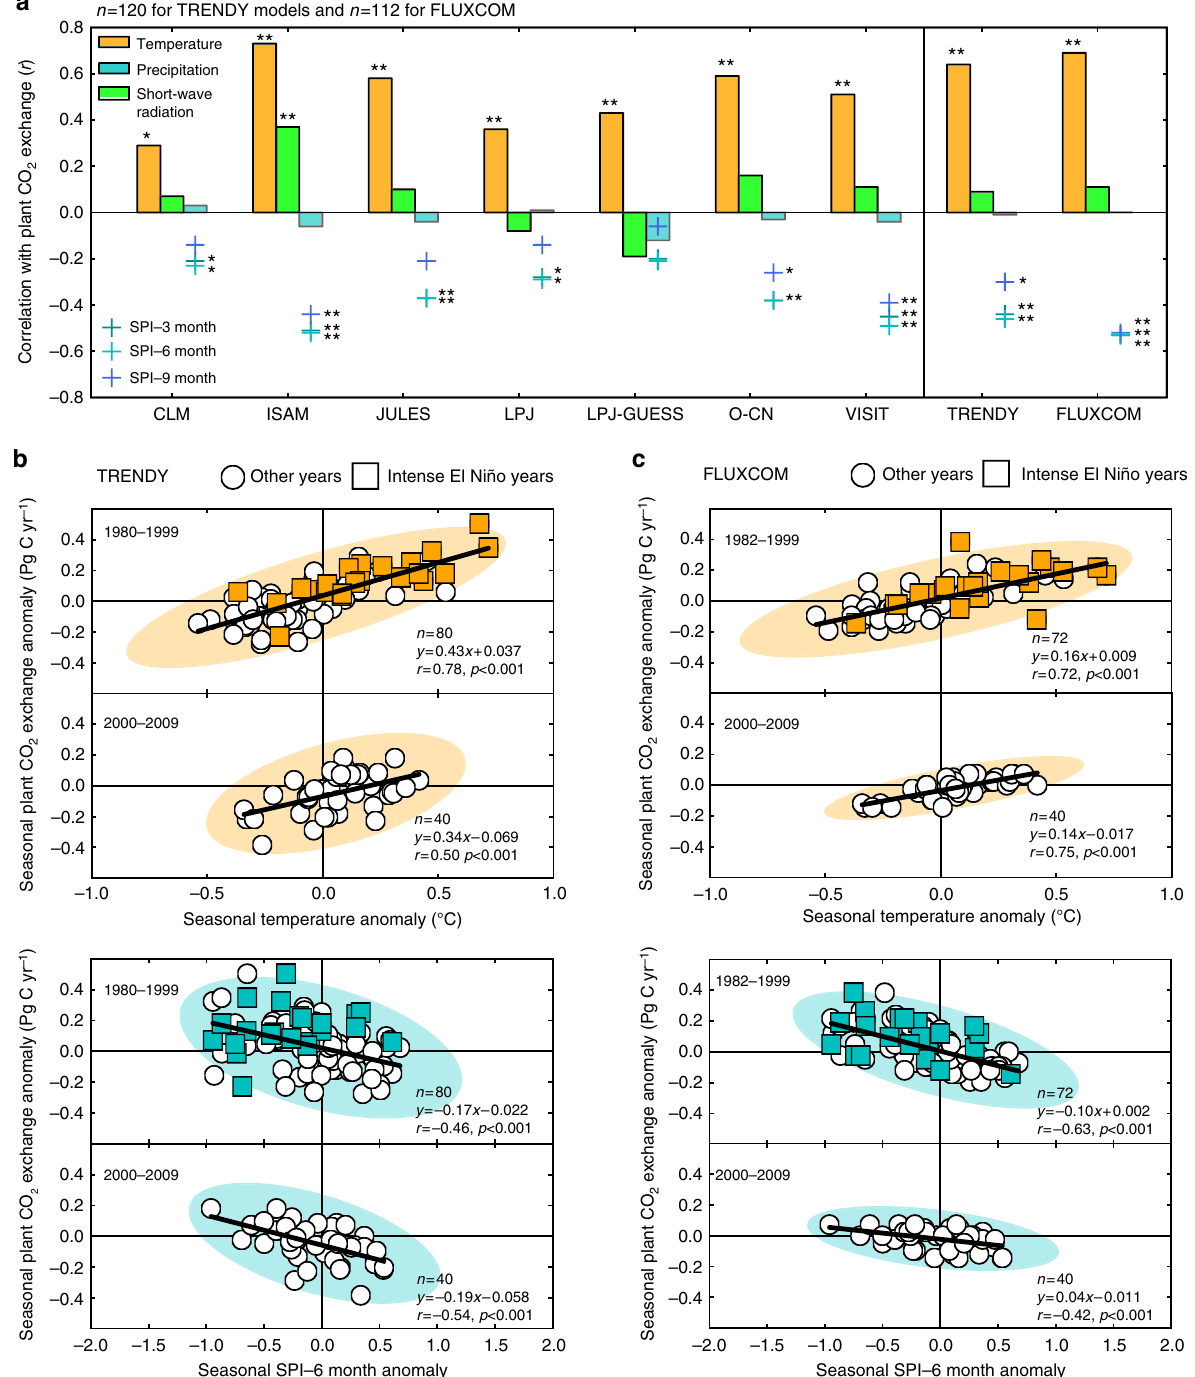
Fig. 5 Climate sensitivity of seasonal plant CO 2 exchange by the biosphere models and empirical upscaling. a Correlation coef fi cients ( r ) in relationship between seasonal anomalies of plant CO 2 exchange induced by the climate effect (TRENDY S2 – S1) and climate variables (temperature, precipitation, short-wave radiation and three types of SPIs) for the period 1980 − 2009. Results are shown for seven individual TRENDY models and the ensemble of the TRENDY and FLUXCOM data. Statistical signi fi cances are indicated by ** p < 0.01 and * p < 0.05. Relationships between seasonal anomalies of plant CO 2 exchange and temperature, and SPI – 6 months for the periods 1980 – 1999 and 2000 – 2009, for b the TRENDY and c FLUXCOM. All relationships are shown along with the 95% con fi dent ellipses and linear regressions. Square markers indicate data corresponding to the intense El Niño years and circle markers to the rest of years. All relationships with SPI are calculated as SPI leads plant CO 2 exchange by 3